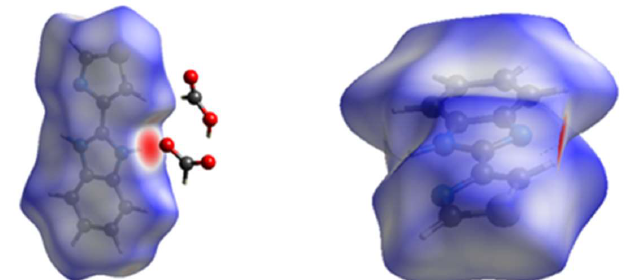
Figure 10. The view of the three-dimensional Hirshfeld surface d norm plot for the TBZ unit in the TBZ-formic acid solvate crystal over the range d norm = –0.7700 to 1.1280 a.u. ( left ) and in the net TBZ crystal plotted over d norm in the range –0.5580 to 1.1414 a.u. ( right ), observed in the a crystallographic plane.